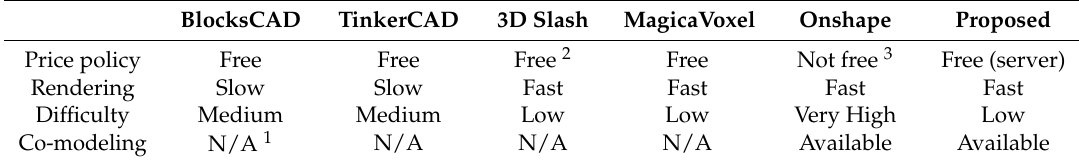
Table 1. Summarized features of the other modeling software and the proposed